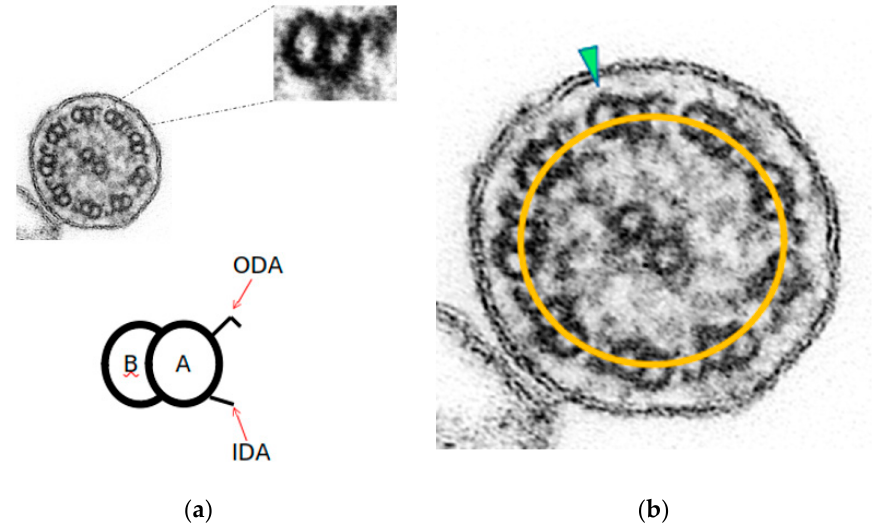
Figure 1. Axonemal symmetry. ( a ) Each microtubule doublet of the ciliary axoneme contains an incomplete B-tubule and a complete A-tubule, with the outer (ODA) and inner (IDA) motor protein dynein arms. ( b ) Ciliary section of ( a ) with preserved axonemal symmetry: both microtubules of each peripheral doublets are aligned with the axonemal circumference (yellow line), and just one doublet is tilted (green arrowhead) (Original magnification ×530,000).